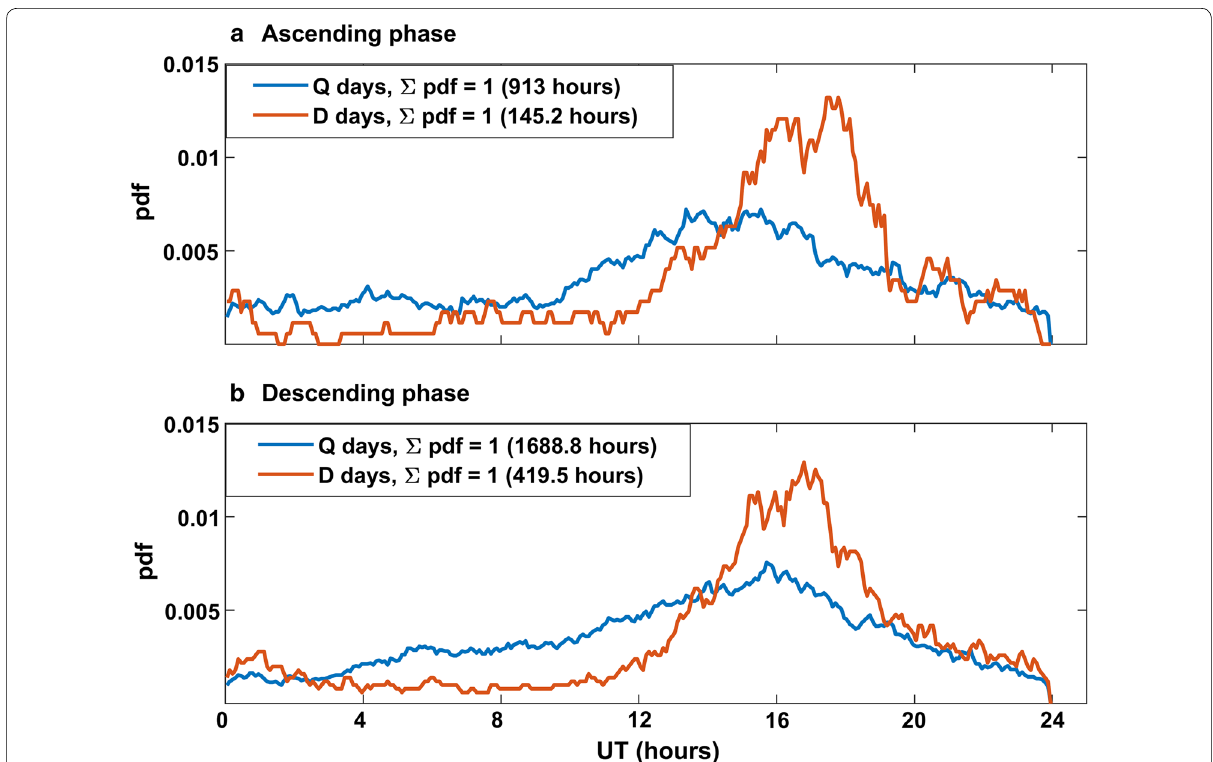
Fig. 6 Local time distribution of occurrence of EMIC waves is shown for a ascending phase and b descending phase. The blue and orange-colored curves represent the quiet days and disturbed days, respectively. The summation of pdf gives 1, which corresponds to the total number of EMIC wave occurrence in hours for respective